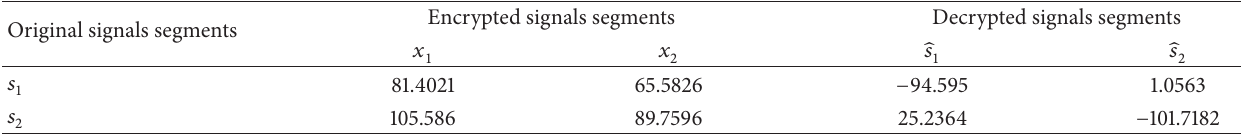
Table 2: SNR (dB) of two original signals segments in two encrypted segments and two decrypted signals segments. Original signals